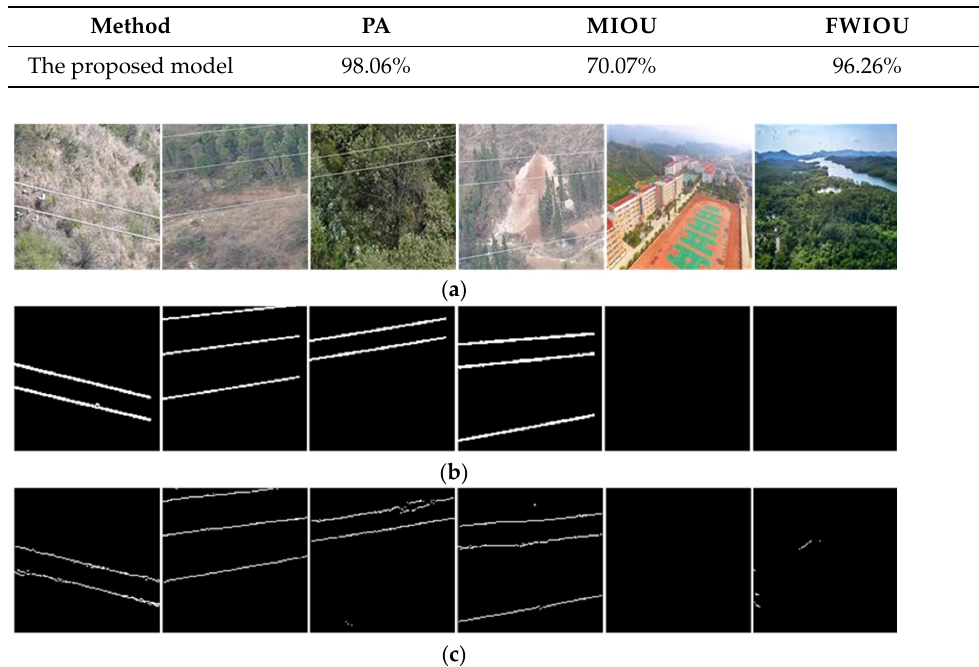
Figure 9. Test results in motion blur environment. The first four show power line scene images, and the last one shows non-power line scene images (order from left to right). ( a ) Power line images in motion blur environment. ( b ) Ground Truth. ( c ) The prediction results of the proposed method. Table 5. The metrics of generalization test.